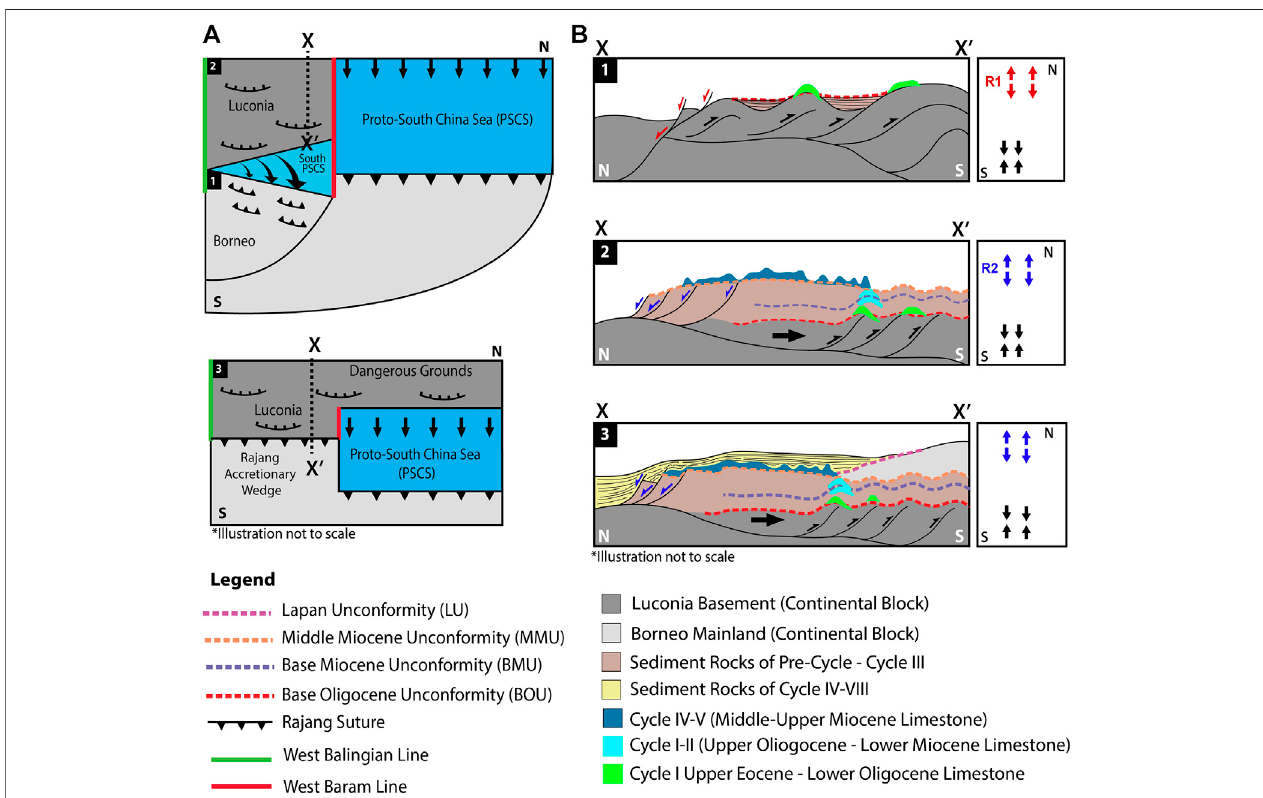
FIGURE 12| (A) Geological model plan viewshowing the closure of Proto-South China Sea (PSCS) and dockingof Luconia continental fragment with Borneo. (B) The cross-sections summarizing thetectonic eventsand growth oflimestoneon topof Luconia shelf. Number 1 – 3 refers toEvent 1 – Event 3.Event1: The closure ofthe southern part of the PSCS (Upper Cretaceous – Eocene) had triggered extensional tectonic from the active rifting of the present day SCS in the north. Event 2: Upper Eocene- Upper Oligocene where extension in the north of Luconia shelf due to second phase of SCS rifting and wrenching tectonic in the south of Luconia. Proto- SCSalmostclosedandsubductedinthenortherpart.Event3:UpperMiocenetopresentdaywhereBorneounderwentregionalcompressionanduplift,inducinggravity driven system that transported the sediment from onshore to offshore, which responsible for the demise of Miocene limestone.